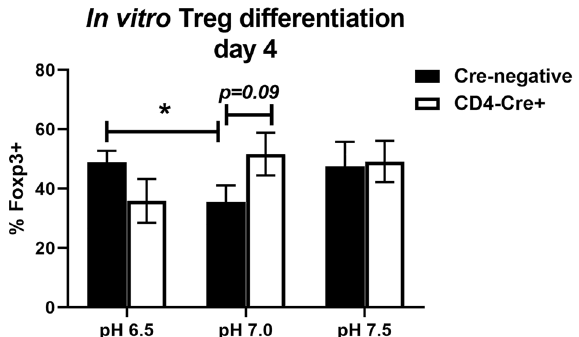
Figure 5. GPR68 does not intrinsically regulate Treg differentiation. Naïve CD4 T cells from GPR68 fl/fl (Cre- negative) and GPR68 fl/fl x CD4-Cre (CD4-Cre +) mice were cultured at pH 6.5, 7.0 and 7.5 with anti-CD3/CD28 beads (1:3 bead:cell ratio), IL-2 (10 ng/mL) and TGF-b (5 ng/mL). On day 4, cells were stained with CD4 and Foxp3, and analyzed by flow cytometry. The percent of CD4 T cells expressing Foxp3 is shown as the mean + /- SEM. Data are combined from four experiments with n = 13–17.